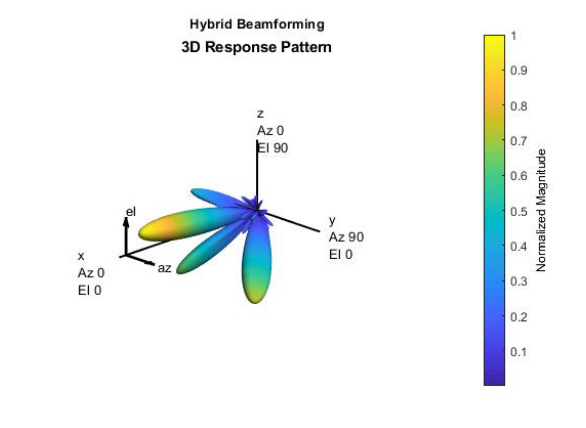
Fig. 13. BER performance for ULA